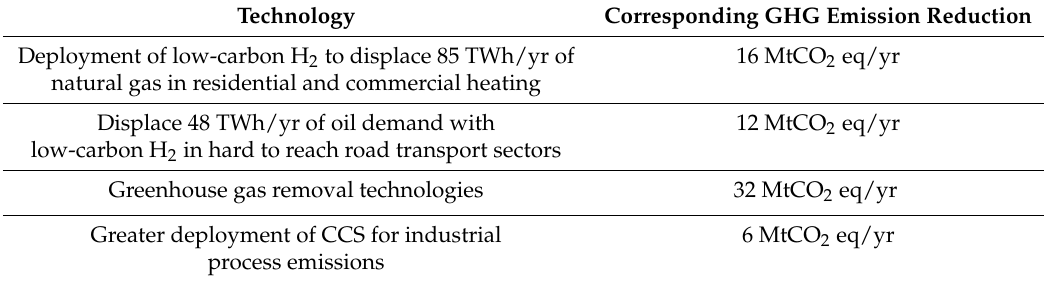
Table 4. Levels of emission reduction achievable by additional technologies over central scenario in Figure